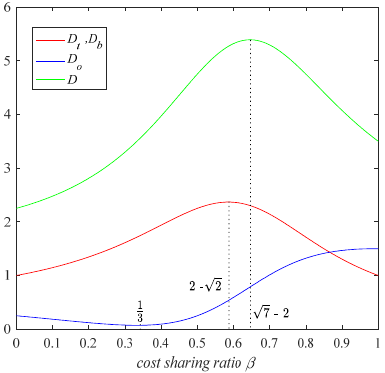
Figure 3. Demand in Scenario U.